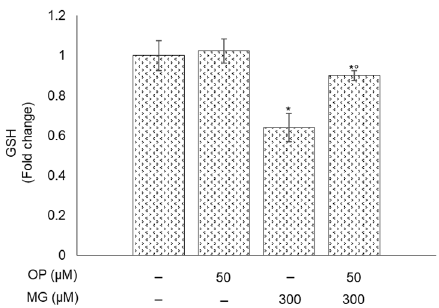
Figure 10. MG-induced responses and their prevention by OP are paralleled by changes of GSH in DPSCs. MG determined a reduction in GSH levels that was prevented by OP pretreatment. Histo- grams indicate the means ± SD of three different cultures, each of which was tested in triplicate. * p < 0.05, significantly different from control untreated cells. ° p < 0.05, compared to MG-treated cells.